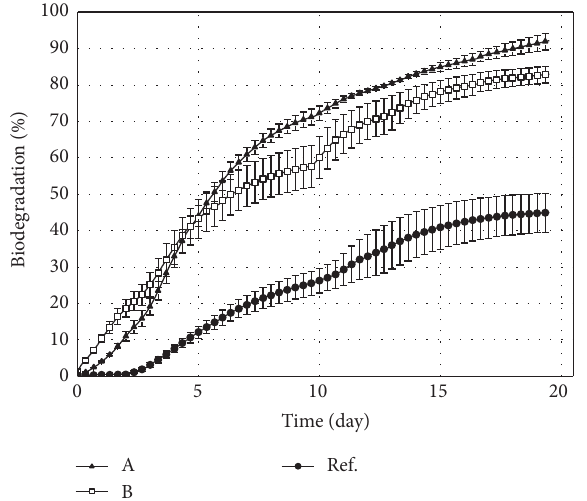
Figure 5: First biodegradation trial: percentage of mineralization of polymers tested. (A, B) PCL composites; (Ref) reference, cellulose. Error bars refer to standard error ( 𝑛 = 3